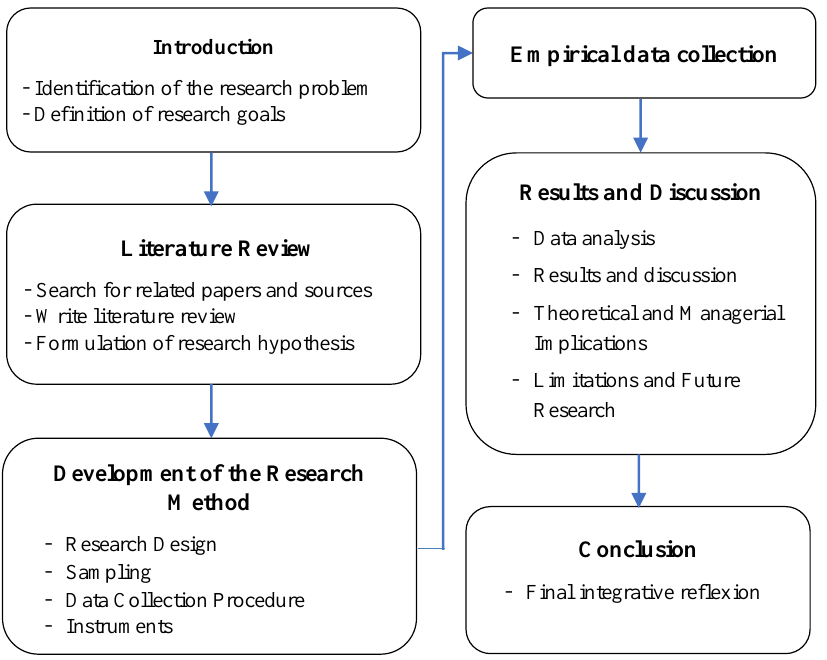
Figure 1. Flowchart of Research